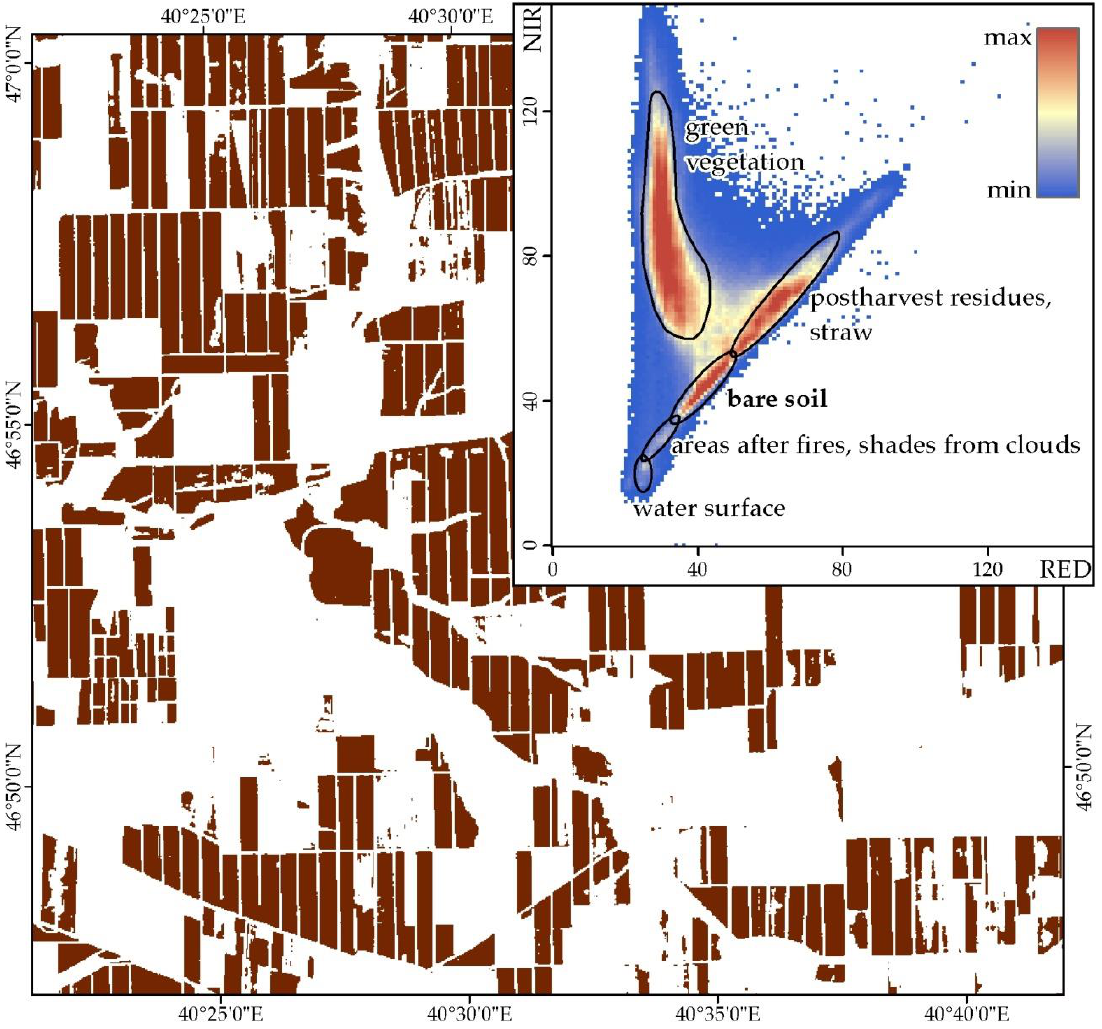
Figure 4. BSS mask and density of the RED-NIR distribution for Landsat scene of June 2007. This area is part of a “tasseled cap” and lies on the soil line [62] between the areas of southern Russia [84]. The location of SNSL only partially coincides with the soil line for climatic